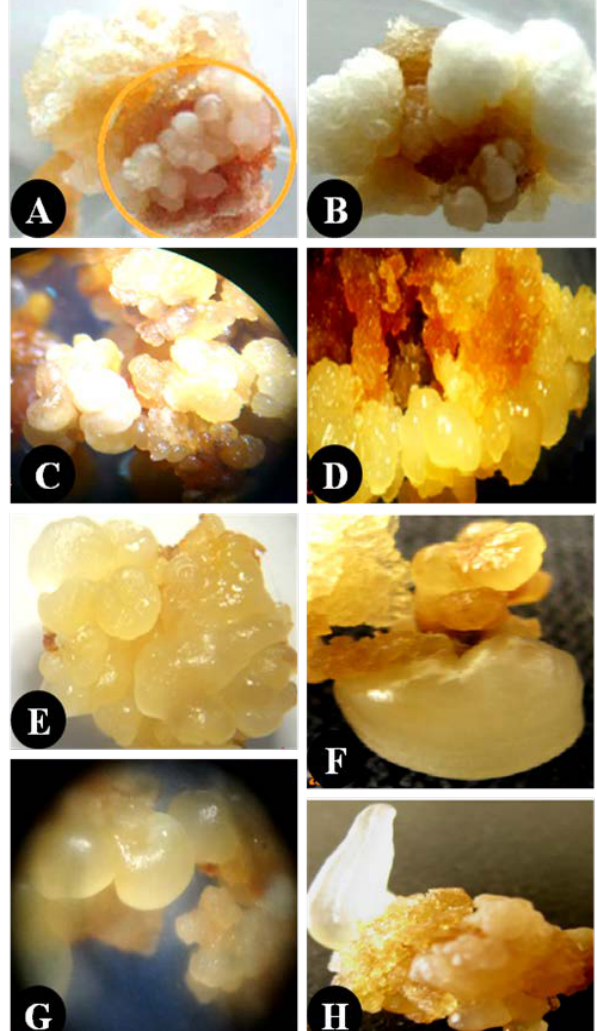
Fig. 1. Effect of explants on callus induction on MS medium supplemented with growth regulator (2mg/l, 2.4-D and 0.5